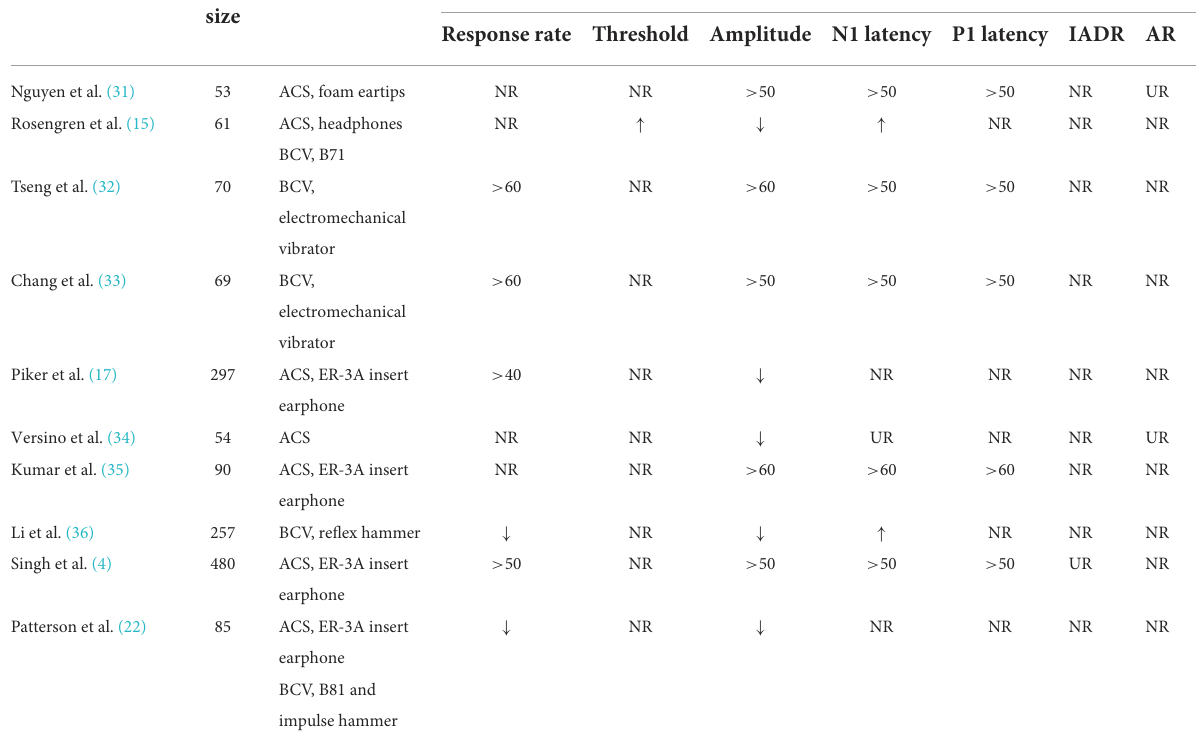
TABLE 6 Literature review of the effects of age on oVEMP response rates and response parameters using ACS and BCV. Study